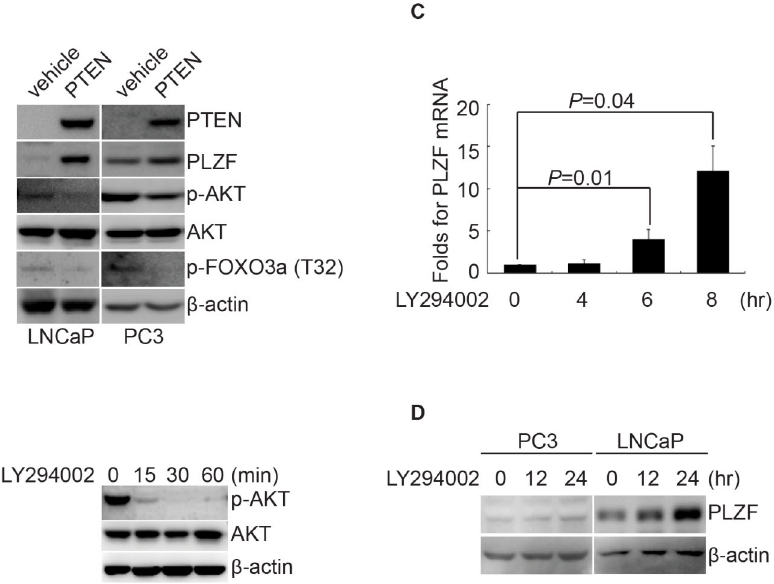
Figure 2. PLZF expression is influenced by PTEN in Prostate cancer cells. A. Western blotting showing that rescued expression of PTEN and the resultant induction of PLZF expression in PC3 and LNCaP cells. PC3 and LNCaP cells were transfected with PTEN or its vehicle plasmid, followed by Western blots for the proteins as indicated. B. PC3 cells were treated with LY294002 for the indicated times, and AKT and its phosphorylated form (p- AKT) were detected by western blots with b -actin as loading control. C. PC3 cells were treated with LY294002 for the indicated time. Then, PLZF mRNA was detected by Q-PCR. Folds of PLZF mRNA against cells in LY294002-treated for 0 hour were calculated, and results were shown as means with bar as SD in three independent experiments with triplicate each. The P values for comparison between line-linked groups were gotten by Student’s t -test. D. PC3 cells and LNCaP cells were treated with LY294002 for the indicated time. PLZF proteins were detected by Western blots with b -actin as loading control. All experiments were repeated individually for three